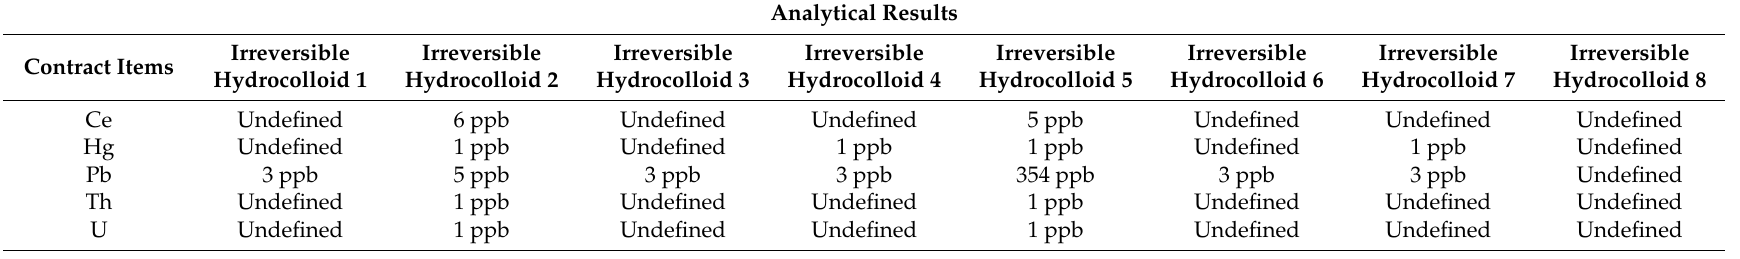
Table 4. Analytical results of the amount of Ce, Hg, Pb, Th and U in irreversible hydrocolloid. Analytical